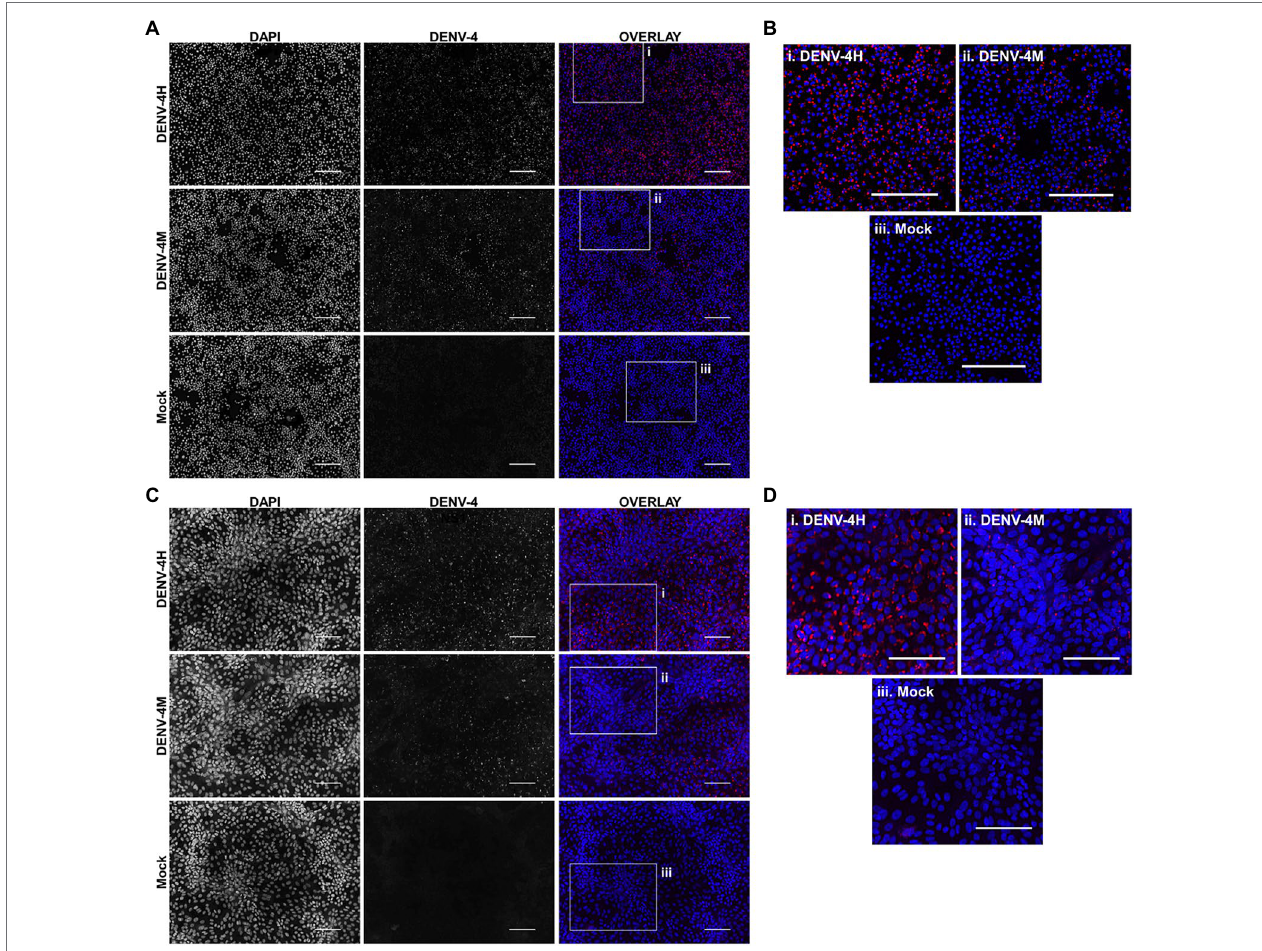
FIGURE 2 | Dengue virus serotype 4 (DENV-4) nonstructural protein 1 (NS1) IFA shows viral replication in Aedes albopictus C6/36 cells and in mammalian Vero E6 cells. DENV-4M or DENV-4H were used to infect C6/36 (A,B) and Vero E6 cells (C,D) at an MOI of 0.01, and cells were processed for NS1 IFA at 4 days post infection (dpi). Red (center column) indicates DENV-4 NS1 and blue (left column) indicates DAPI DNA counterstain. Representative images were chosen from three independent experiments. Scale bar = 100 μ